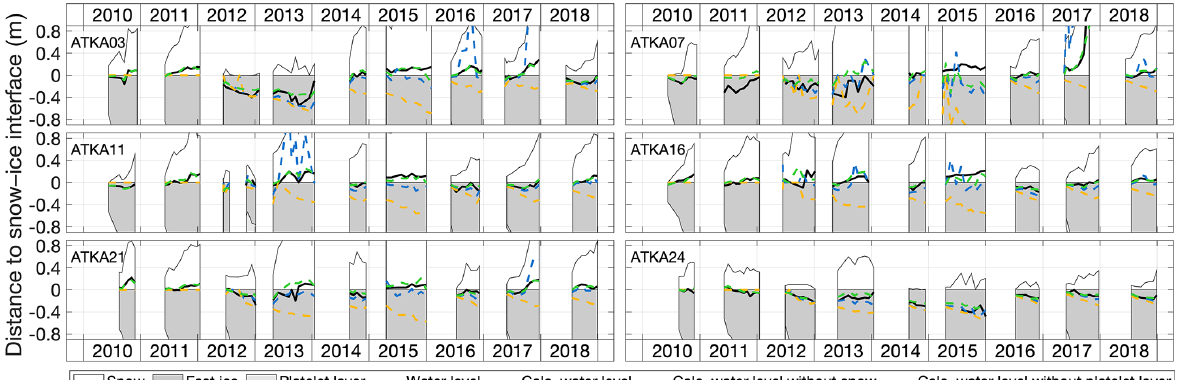
Figure 5. Close-up of Fig. 4 which highlights the location of the water level with respect to the snow–ice interface (which has the opposite sign of the freeboard) as measured in the field (black solid line) and as calculated according to Eqs. (1) and (2) including snow and platelet-layer thickness (blue dashed line), neglecting the snow cover (dashed yellow line) and platelet layer (dashed green line), respectively. Please note that, for the purpose of better illustration, we depict here the actual location of the water level rather than the freeboard (the only difference being the opposite sign). This means that, if the water level is above the snow–ice interface, this is depicted in the figure accordingly, while the actual freeboard carries a negative sign, and vice versa. The reference depth of 0 represents the snow–ice